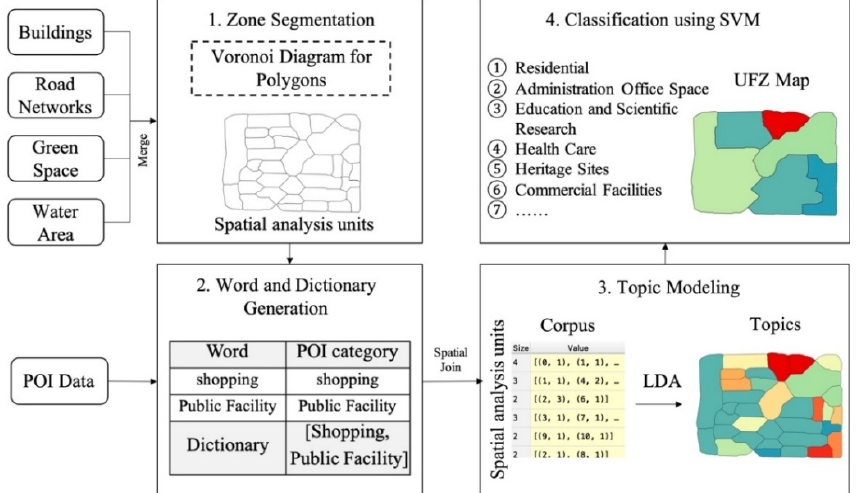
Figure 5. Methodology flowchart. (1) Zone segmentation. The Voronoi diagram for the polygon method is employed to generate spatial analysis units by integrating building, green space, water area, and road (2) Word and dictionary generation. Each POI category is regarded as a single word. The dataset of all POI categories contained in a certain spatial analysis unit is regarded as a dictionary. (3) Topic feature extraction. Each spatial analysis unit is regarded as a document, and the semantic features of each spatial analysis unit are mined with the LDA topic model to better classify UFZs. (4) UFZ classification. The topics extracted from the LDA topic model are applied as semantic features. A multiclass SVM classifier is trained and applied to classify spatial analysis units into UFZs. 4.1. Zone Segmentation In UFZ mapping, spatial analysis units should be determined first. The TAZ (traffic analysis zone) has been adopted as the spatial analysis unit in numerous studies involving UFZ division, urban land use classification, and scene classification [5,8,11,27]. However, highly mixed urban functions do exist in reality in each TAZ, and even a single building can contain different functions [28]. Buildings are a basic spatial component of urban ar- eas, and their spatial structure creates a link between buildings and social functions. In theory, POIs within the same building exhibits a stronger spatial context than do POIs in different buildings. By dividing buildings into units, we can effectively capture the rela- tionship between buildings in space. More accurately, space division assigns each build- ing the meaning of functional influence on its surrounding spatial environment. There- fore, we propose a spatial segmentation method with buildings as basic anchors based on the Voronoi diagram to generate a more fine-grained spatial analysis unit. 4.1.1. Voronoi Diagram for Points The division of spatial analysis units divides the research area according to specific rules. The core of the proposed zone segmentation method is the Voronoi diagram (Thies- sen polygons), which is a space partitioning method that generates a series of polygons from a set of seeds (Figure 6). It’s named after the famous Russian mathematician Georgy Voronoi. Any point in each polygon is the closest to the seed point in the polygon, so each polygon can be regarded as the influence area of the seed. Therefore, the zone segmenta- tion method based on Thiessen polygons provides a more practical geographical signifi- cance than does the grid-based division method.